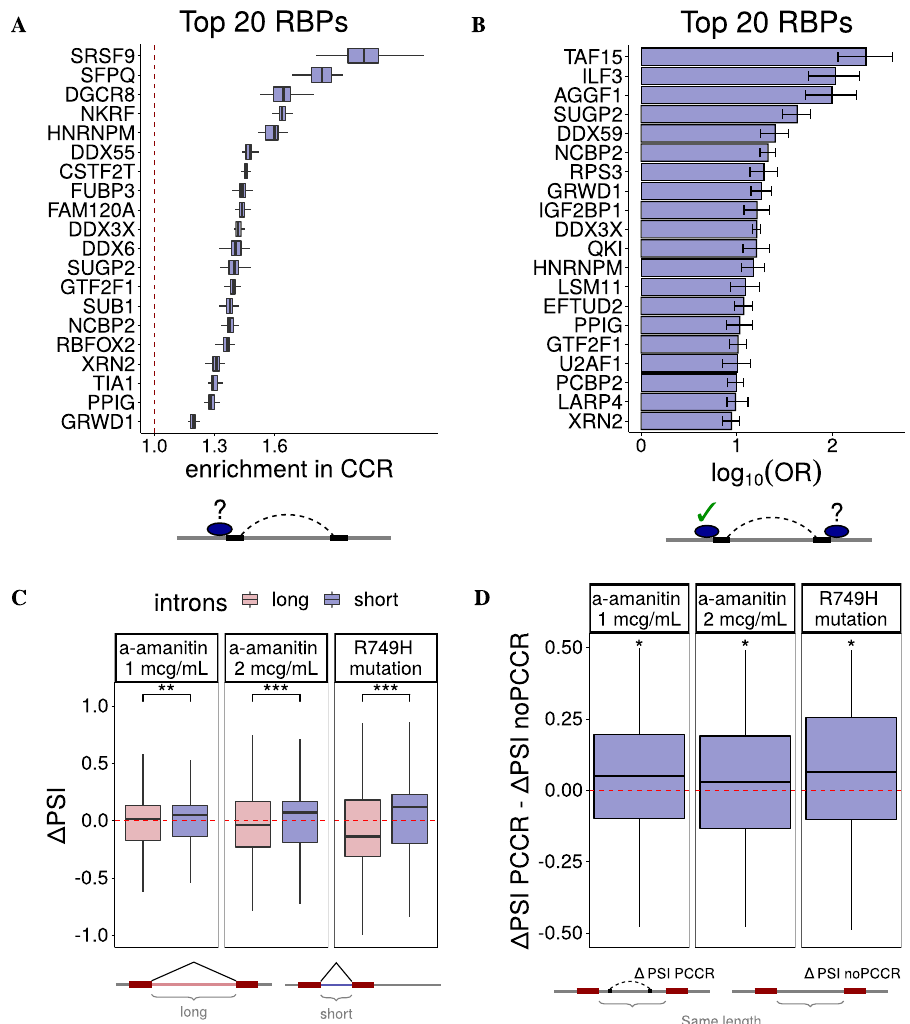
Fig. 5 RNA-binding proteins (RBP). A According to eCLIP pro fi les, CCRs are enriched within binding sites of some RBPs (top 20 RBPs are shown). The RBPs that show depletion of CCRs are listed in Fig. S12. Boxplots represent n = 40 random shifts of CCR within CIR. B The odds ratios (OR) of RBP binding near both CCR in PCCR given that RBP binds near at least one CCR indicate that PCCRs are enriched with forked eCLIP peaks. Error bars represent the 95% con fi dence intervals. C The change of inclusion rate ( ΔΨ ) of exons following short introns ( n = 2844, 2650, and 4032 for 1 μ g/mL, 2 μ g/mL, and R749H mutant, respectively) vs. exons following long introns ( n = 2931, 2762, and 3807 for 1 μ g/mL, 2 μ g/mL, and R749H mutant, respectively) in response to RNA Pol II slowdown with α -amanitin and in the slow RNA Pol II mutant R749H 71 . D The difference between the inclusion rate change of exons following introns with a PCCR ( ΔΨ PCCR) and the inclusion rate change of exons following introns of the same length, but without PCCRs ( ΔΨ noPCCR) in response to RNA Pol II slowdown ( n = 191, 184, and 156 for 1 μ g/mL, 2 μ g/mL, and R749H mutant, respectively). In all panels, boxplots are represented by the median, upper and lower quartiles, upper and lower fences without outliers; *, **, and *** denote a statistically discernible difference at the 5%, 1%, and 0.1% signi fi cance level, respectively (two-tailed Mann – Whitney and Wilcoxon ’ s tests, in panel D with respect to H 0 : ΔΨ PCCR − ΔΨ noPCCR =